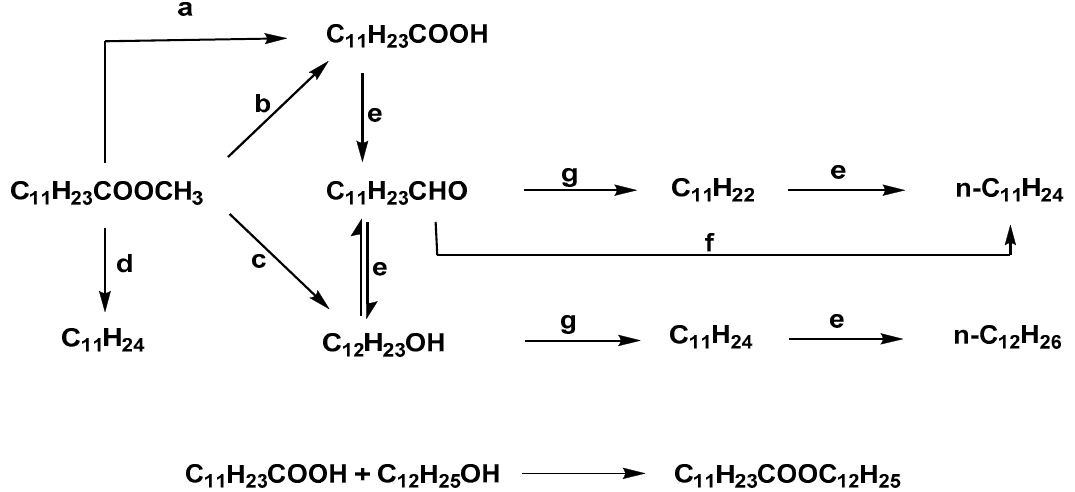
Figure 5. Tentative reaction network of methyl palmitate HDO over silica-supported nickel phosphide catalysts adapted from the work of [87].